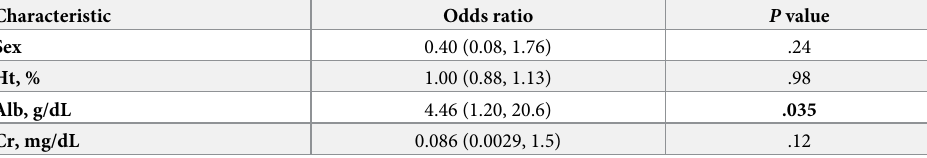
Table 2. Factors related to arterial phase artifacts in the clinical study: Logistic regression